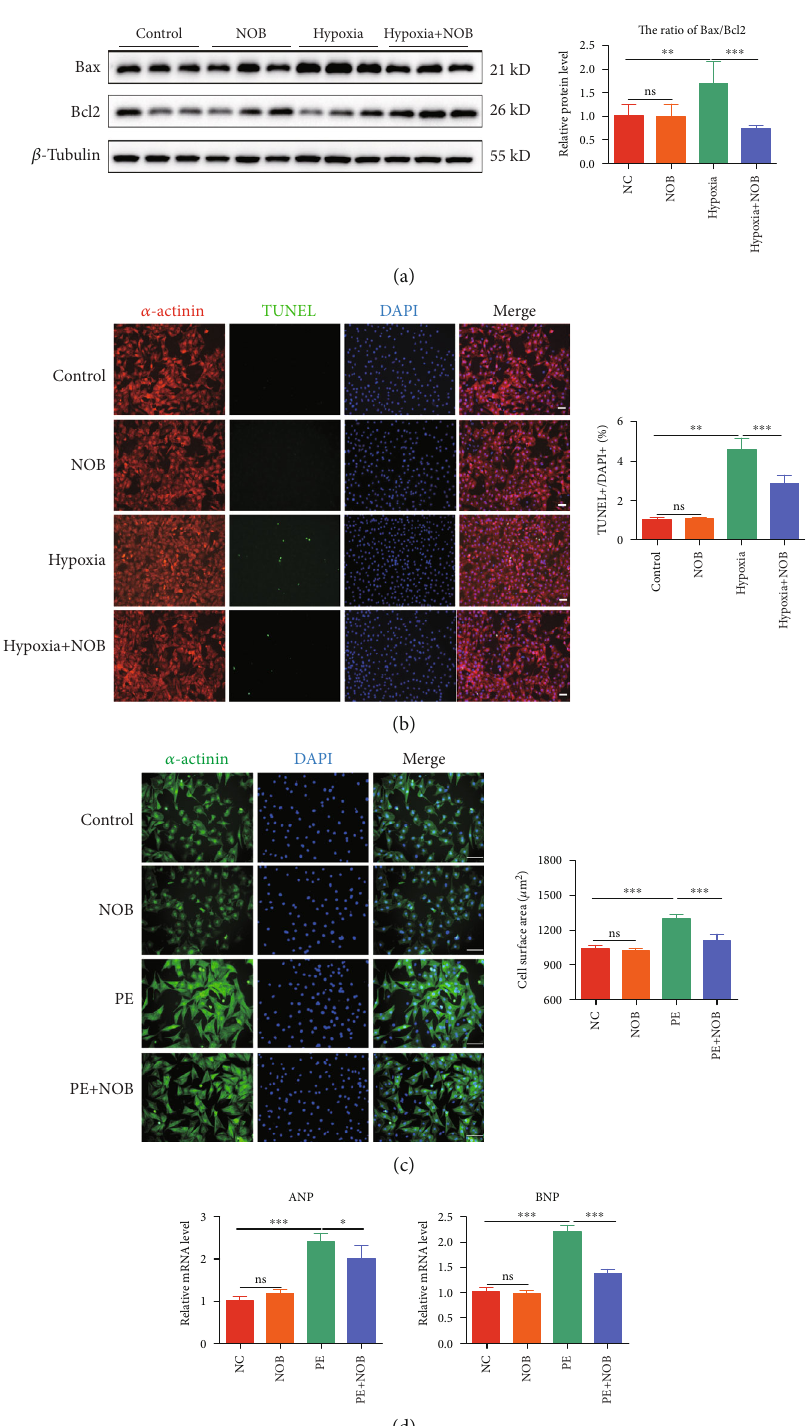
Figure 3: NOB attenuates hypoxia-induced apoptosis and PE-induced cardiac hypertrophy in NRVMs. (a) Western blot analysis of Bax and Bcl2 indicated that the Bax/Bcl2 ratio increased after hypoxia and decreased with NOB administration ( n = 6 per group). (b) TUNEL staining indicated that the rate of apoptosis-positive NRVMs was reduced after NOB interference compared with that in the hypoxia group (blue: nuclei; red: α -actinin; and green: apoptotic-positive nuclei; scale bars: 100 μ m, n = 6 per group). (c) Immuno fl uorescence staining in NRVMs (blue: nuclei; green: α -actinin; scale bars: 100 μ m) showed that the NRVM cell size increased in the PE group compared with the control group, which could be reversed by NOB intervention ( n = 6 per group). (d) qRT-PCR showed that the expression levels of ANP and BNP were lower in the NOB intervention group than in the PE-induced group ( n = 6 per group). Data are presented as mean ± SD . ∗ P < 0 : 05 ; ∗∗ P < 0 : 01 ; ∗∗∗ P < 0 : 001 ; ns P > 0 : 05 . NOB: nobiletin; NRVMs: neonatal rat ventricular cardiomyocytes; PE: phenylephrine; TUNEL: terminal deoxynucleotidyl transferase-mediated dUTP-biotin nick end labeling; ANP: natriuretic peptide type A; BNP: natriuretic peptide